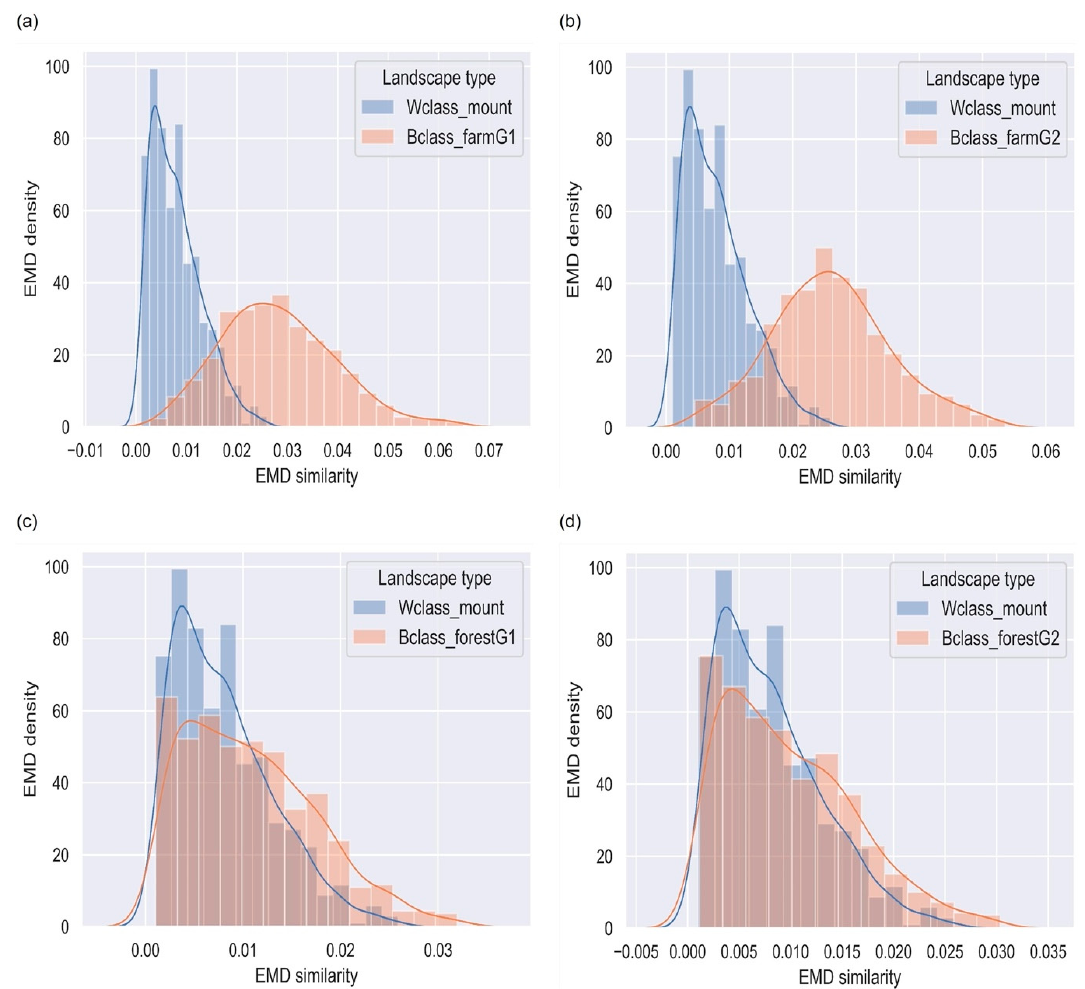
Figure 10. Original image histogram of oriented gradients (HoG) comparison. Image EMD values distribution for mountain, forest, and farm patterns is depicted in ( a – d ). ( a , b ) Show within-class (mountain vs. mountain) and between-class (mountain vs. farm); meanwhile, ( c , d ) depict within-class (mountain vs. mountain) and between-class (mountain vs. forest).